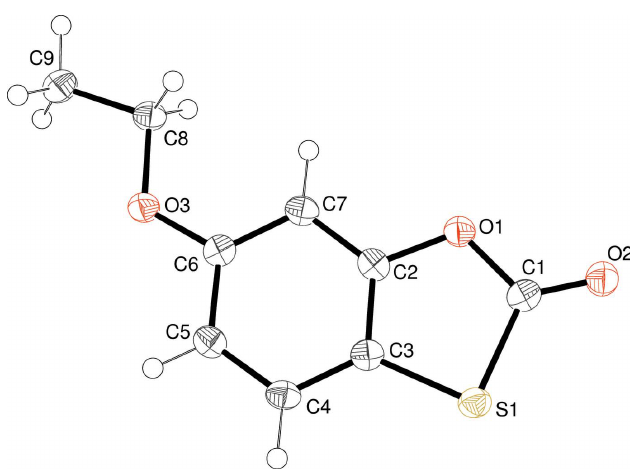
Figure 1 The molecular structure of (I), showing 50% displacement